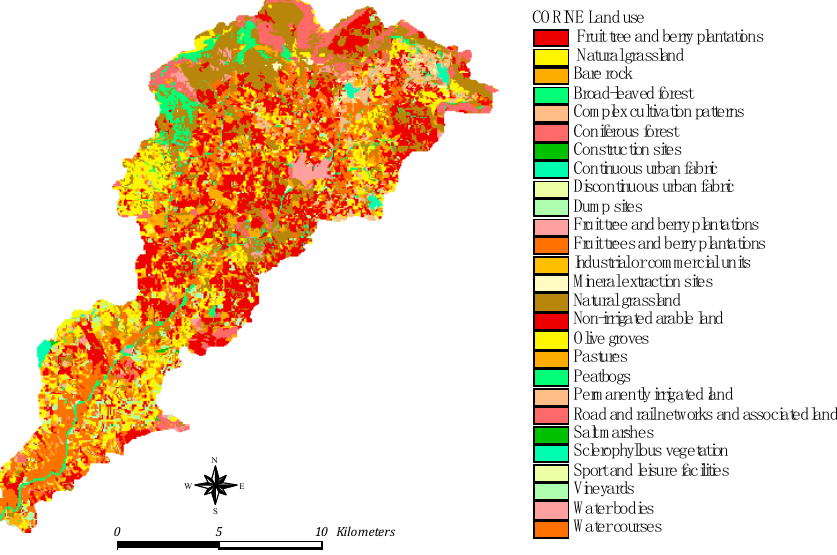
Figure 4. Land use classes based on the CORINE Land Cover map for the Magazzolo catchment.